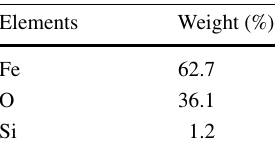
Fig. 2 EDS spectra of magnetic